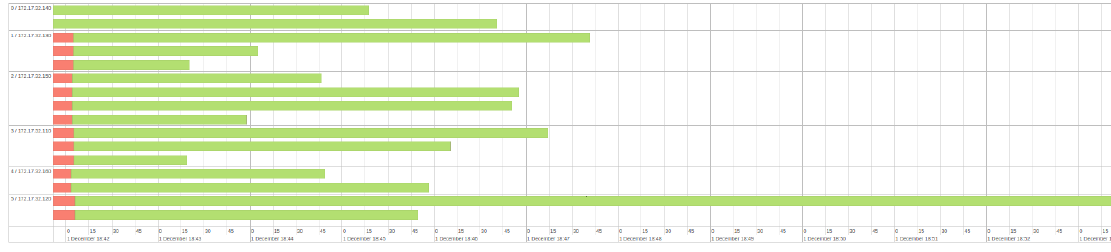
Figure 6. The unbalanced tasks work